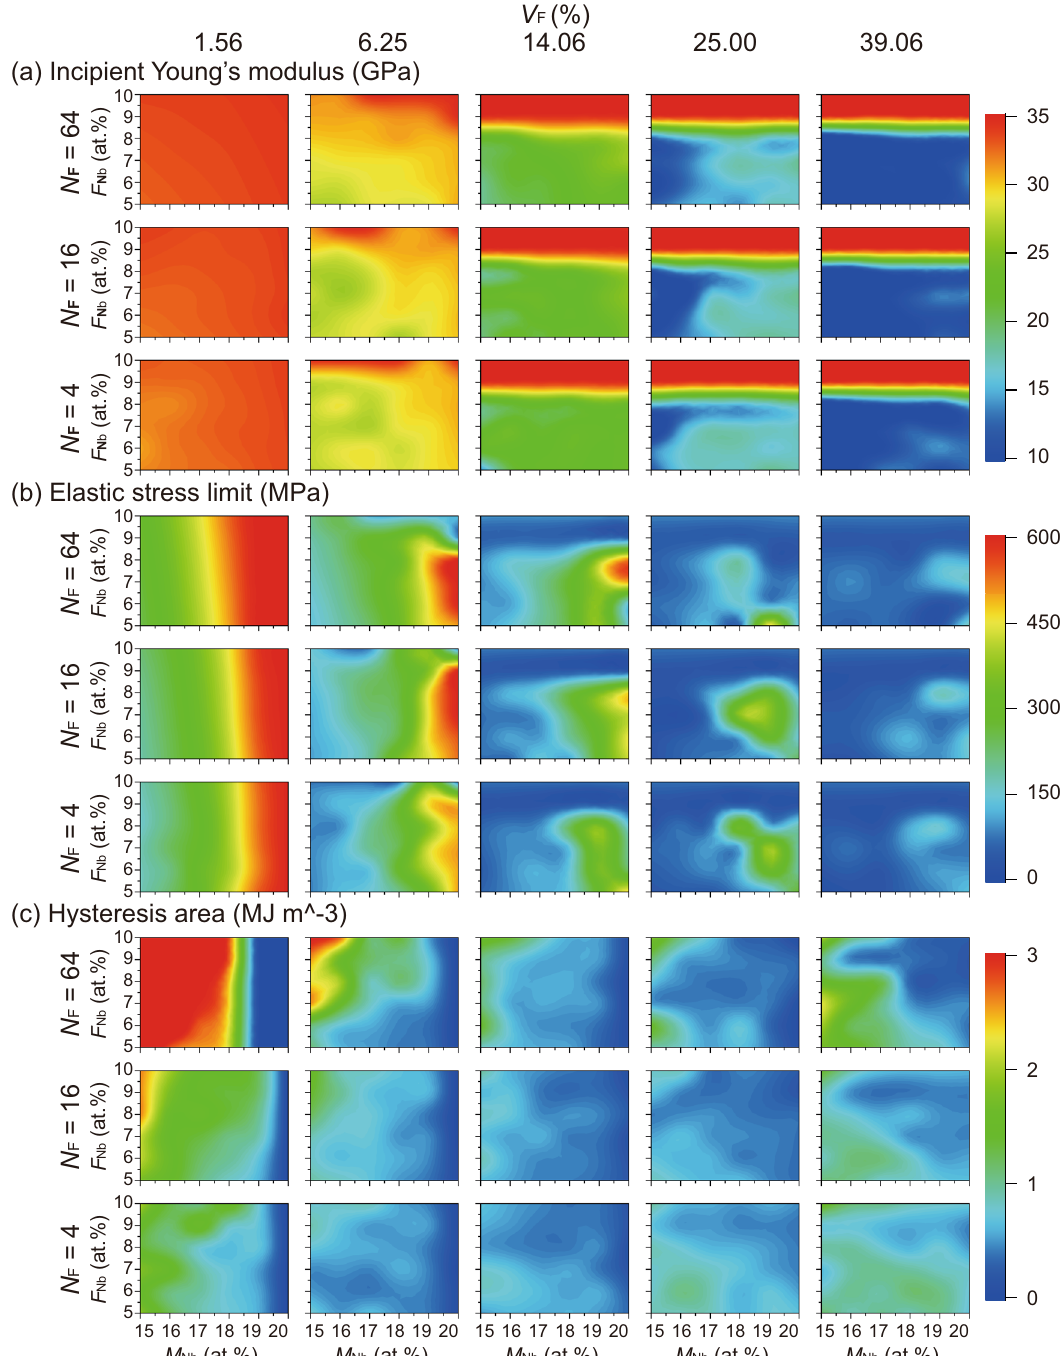
Fig. 2 Mapping results of the HTP phase- fi eld simulations. a The apparent incipient Young ’ s modulus, b the apparent elastic stress limit, and c the hysteresis